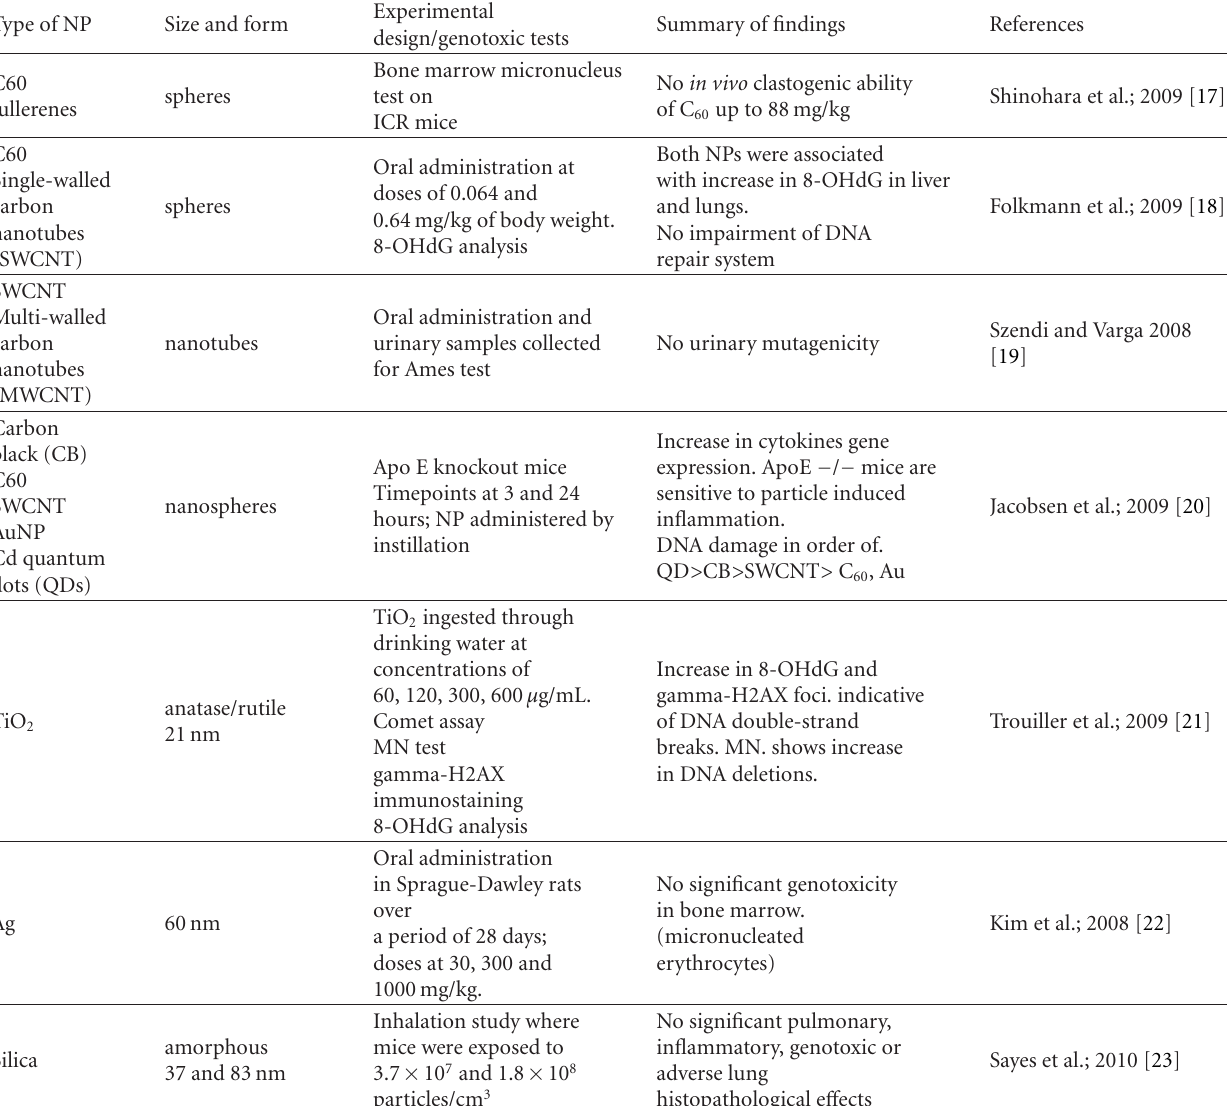
Table 1: Selected in vivo genotoxicity studies on